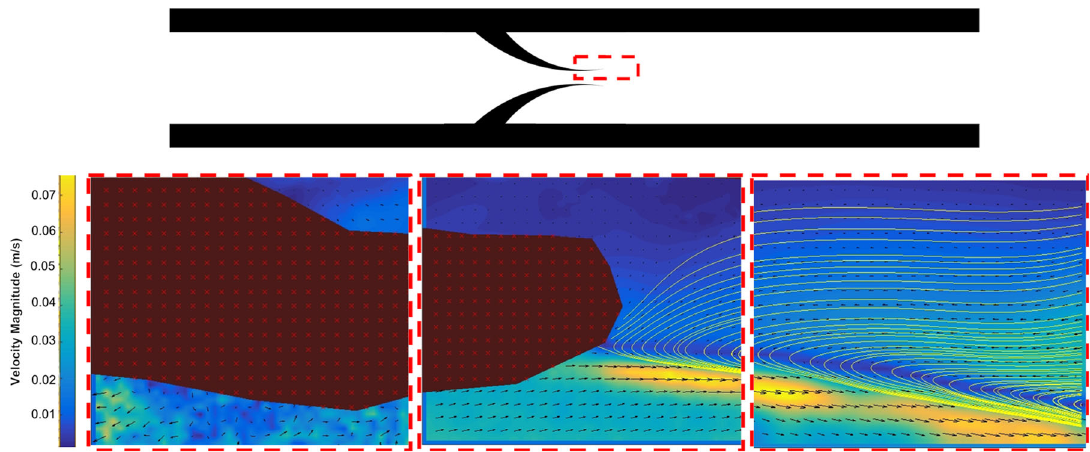
Fig. 8 Vortex formation at Re = 163. A vortex forms at the valve tip (here only half vortex is shown as observed from multiple